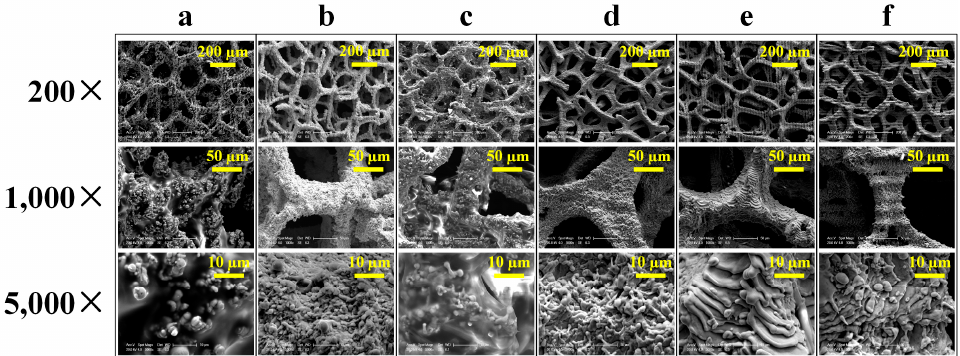
Figure 5. SEM micrographs at different magnifications for laser-heat treated Cu foams processed using different combinations of scanning speed and line spacing: ( a ) scanning speed of 100 mm/s and line spacing of 20 μ m; ( b ) scanning speed of 150 mm/s and line spacing of 20 μ m; ( c ) scanning speed of 200 mm/s and line spacing of 20 μ m; ( d ) scanning speed of 300 mm/s and line spacing of 20 μ m; ( e ) scanning speed of 100 mm/s and line spacing of 30 μ m; ( f ) scanning speed of 200 mm/s and line spacing of 30 μ m.